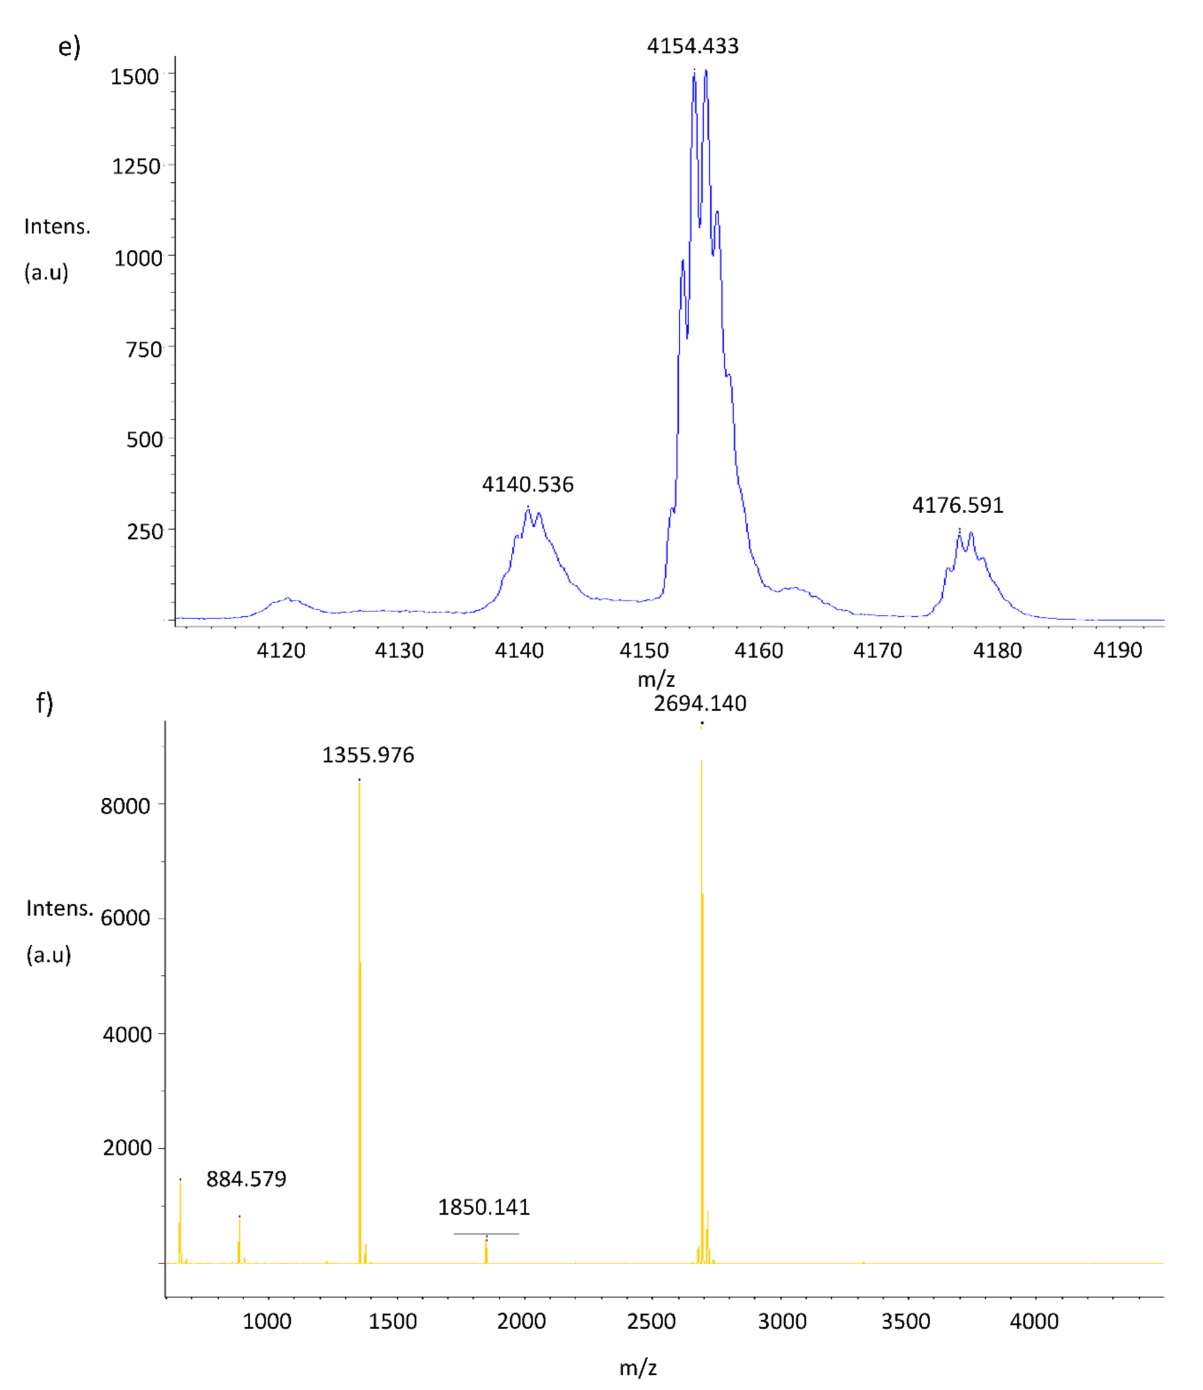
Figure 5. Mass spectrometry profiles of NE-incubated peptides. Mass spectrometry profiles of ( a , b ) Sn1b, ( c , d ) SnE1 and SnV1 ( e , f ) following incubation in the presence ( b , d , f ) or absence ( a , c , e ) of NE for 4 h. The relative intensity of the ions (arbitrary units, au) is shown on the y-axis, and the mass to charge ratio ( m / z ), corresponding to the molecular masses (Daltons) are shown on the